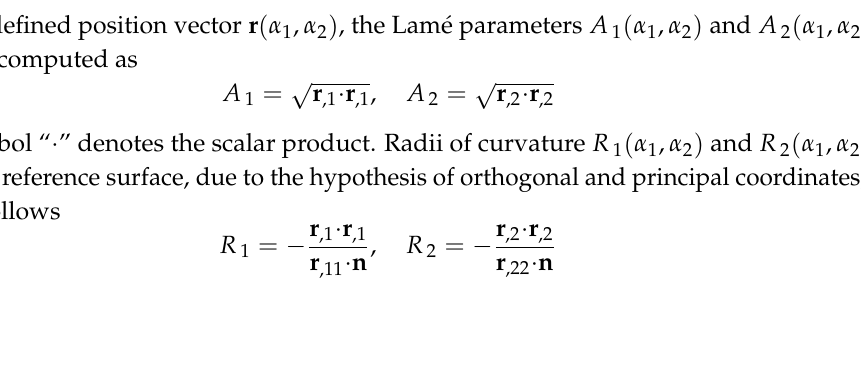
Figure 1. Doubly-curved panel representation and lamination scheme.